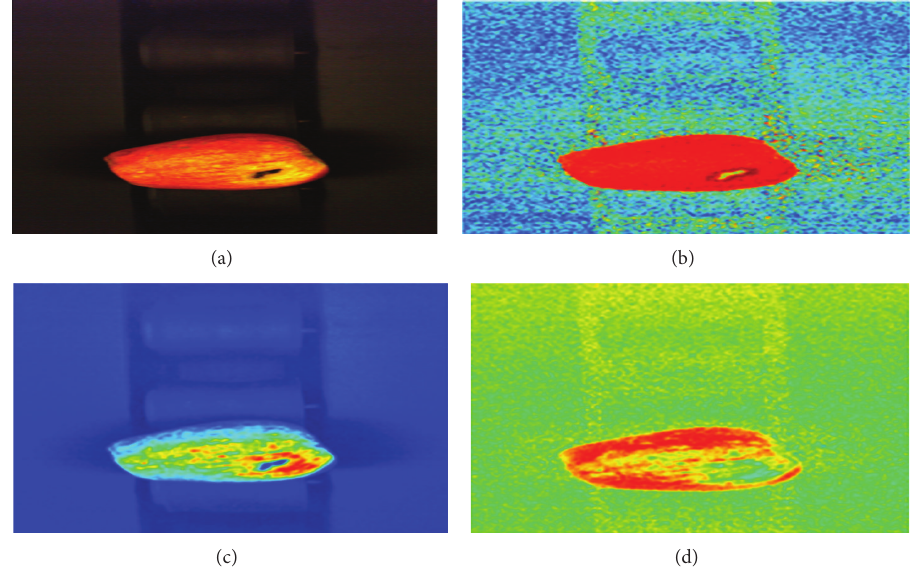
Figure 6: (a) Original image. Image of the (b) “ 𝑆 ” component of HSV color spaces, (c) “ 𝑌 ” component of CIE 𝑋𝑌𝑍 color space, and (d) “ 𝑎 ” component of CIE 𝐿 ∗ 𝑎 ∗ 𝑏 ∗ color